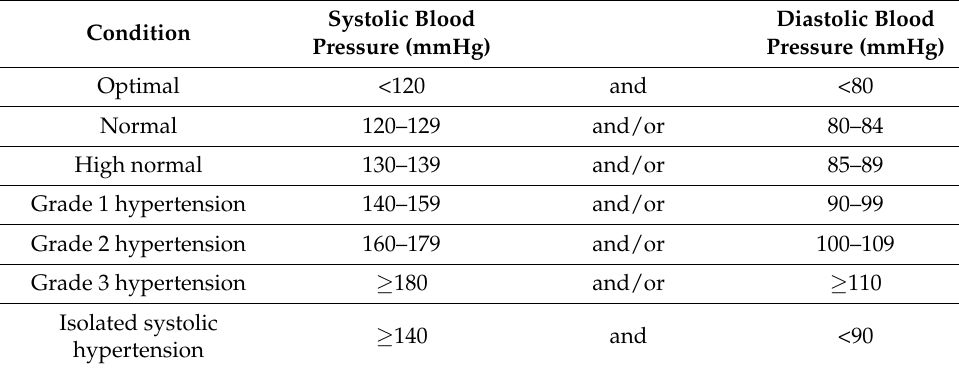
Table 3. Definition of hypertension and classification of BP.